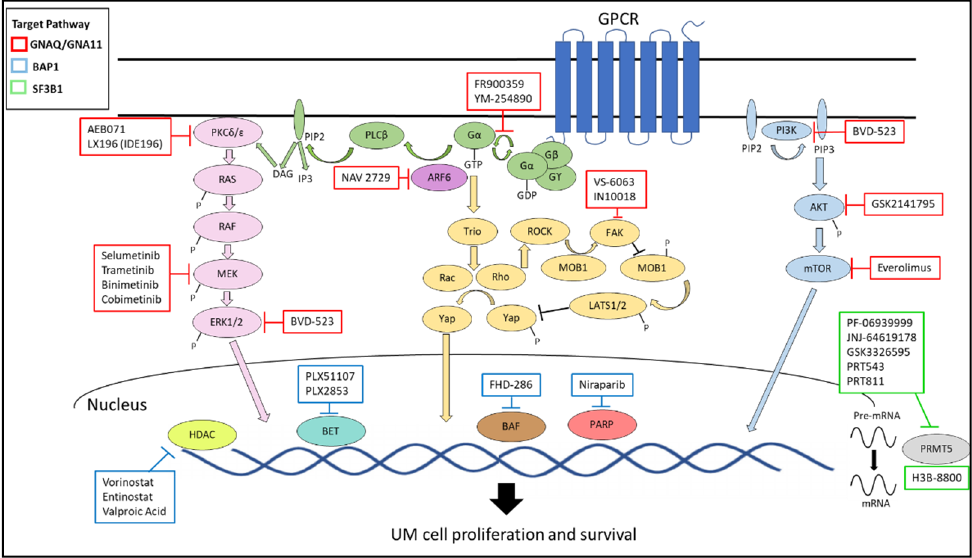
Figure 2. Signaling Pathways in UM. Adapted from “Targeted Therapy of Uveal Melanoma: Recent Failures and New Perspectives” by Michela Croce et al. 846 [121]. Table 2. Ongoing Targeted Therapy Trials for